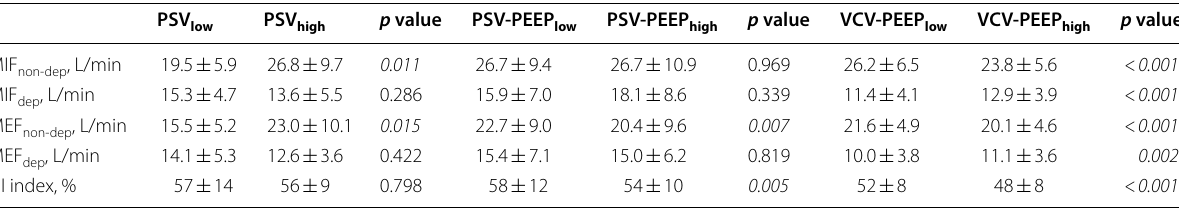
Table 2 Effects of higher vs. lower pressure support and PEEP on regional airflows and GI index measured by electrical impedance tomography